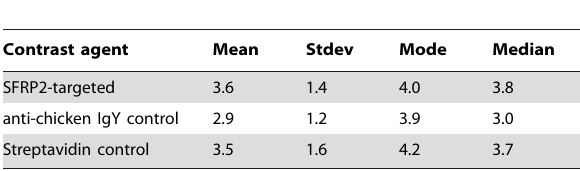
Table 1. Size-distribution of targeted and control contrast agent diameters ( m